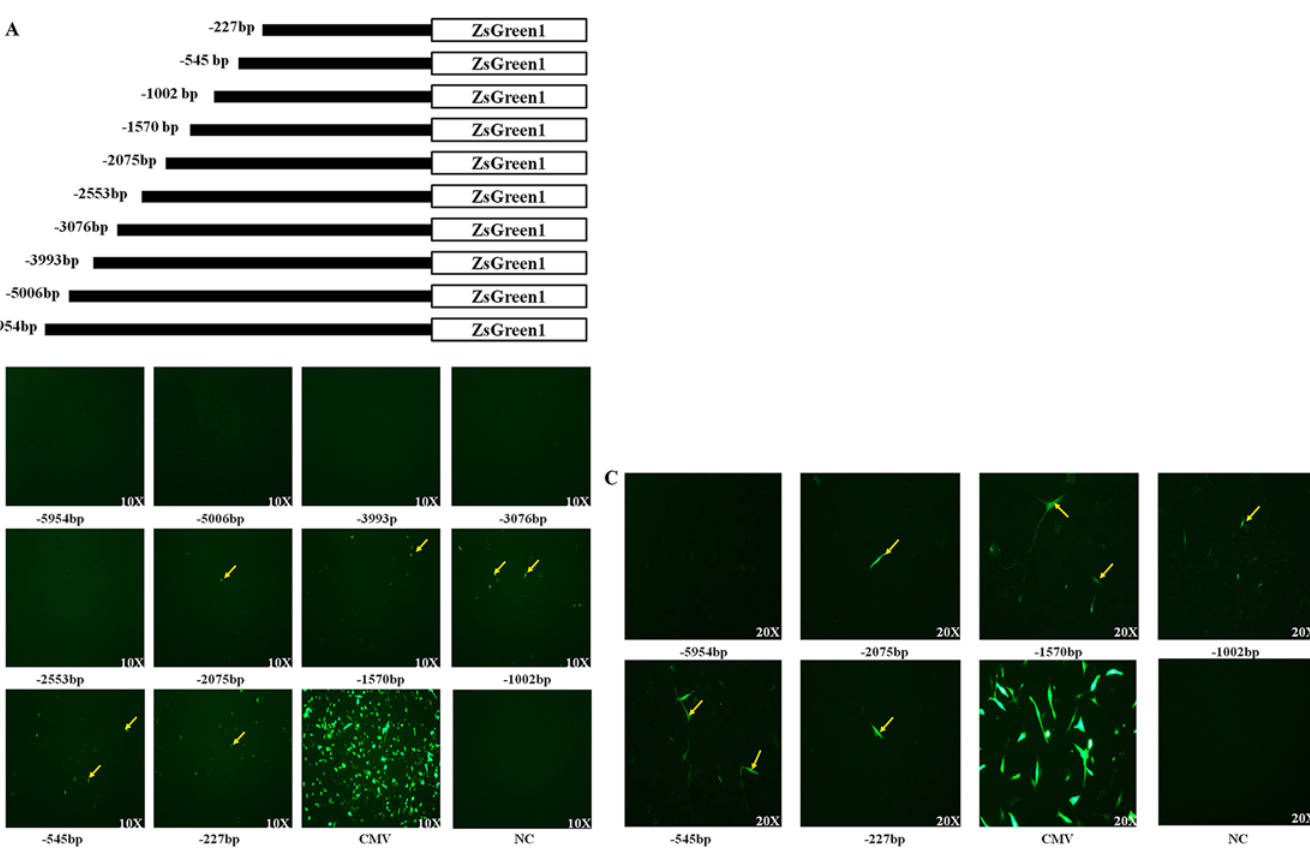
Fig 9. Transcriptional activity of a series of KRTAP11-1 promoter deletion constructs in cells. (A) The construction of the truncated promoter vectors. (B) Transfection of SEFs with different truncated promoter vectors. The GFP signal was observed in the regions of -1,570 bp, -1,002 bp, -545 bp and -227 bp. (C) Transfection of HHORS cells with different truncated promoter vectors. The signal was detected in the regions of -2,075 bp, -1,570 bp, -1,002 bp, -545 bp and -227 bp. The number under the picture shows the relative distance from the 5 0 site of the truncated promoter to the sheep KRTAP11-1 gene translation start site; CMV promoter and Negative